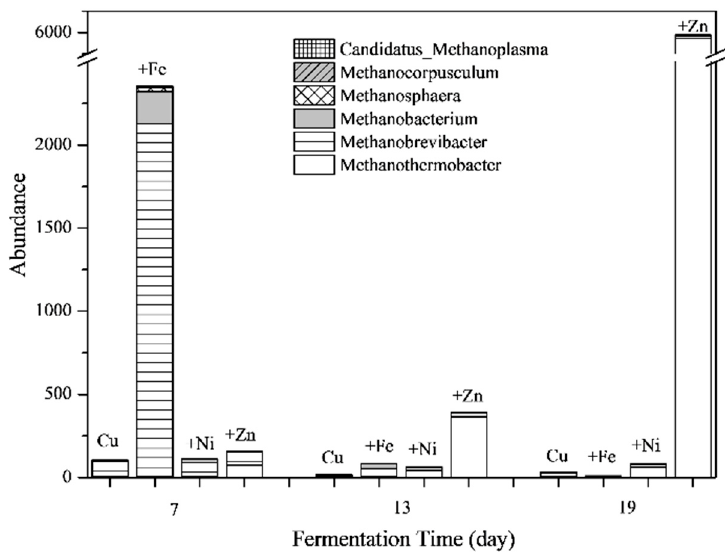
Figure 8. Responses of the absolute abundance of methanogens to Fe, Ni and Zn combined with Cu addition.